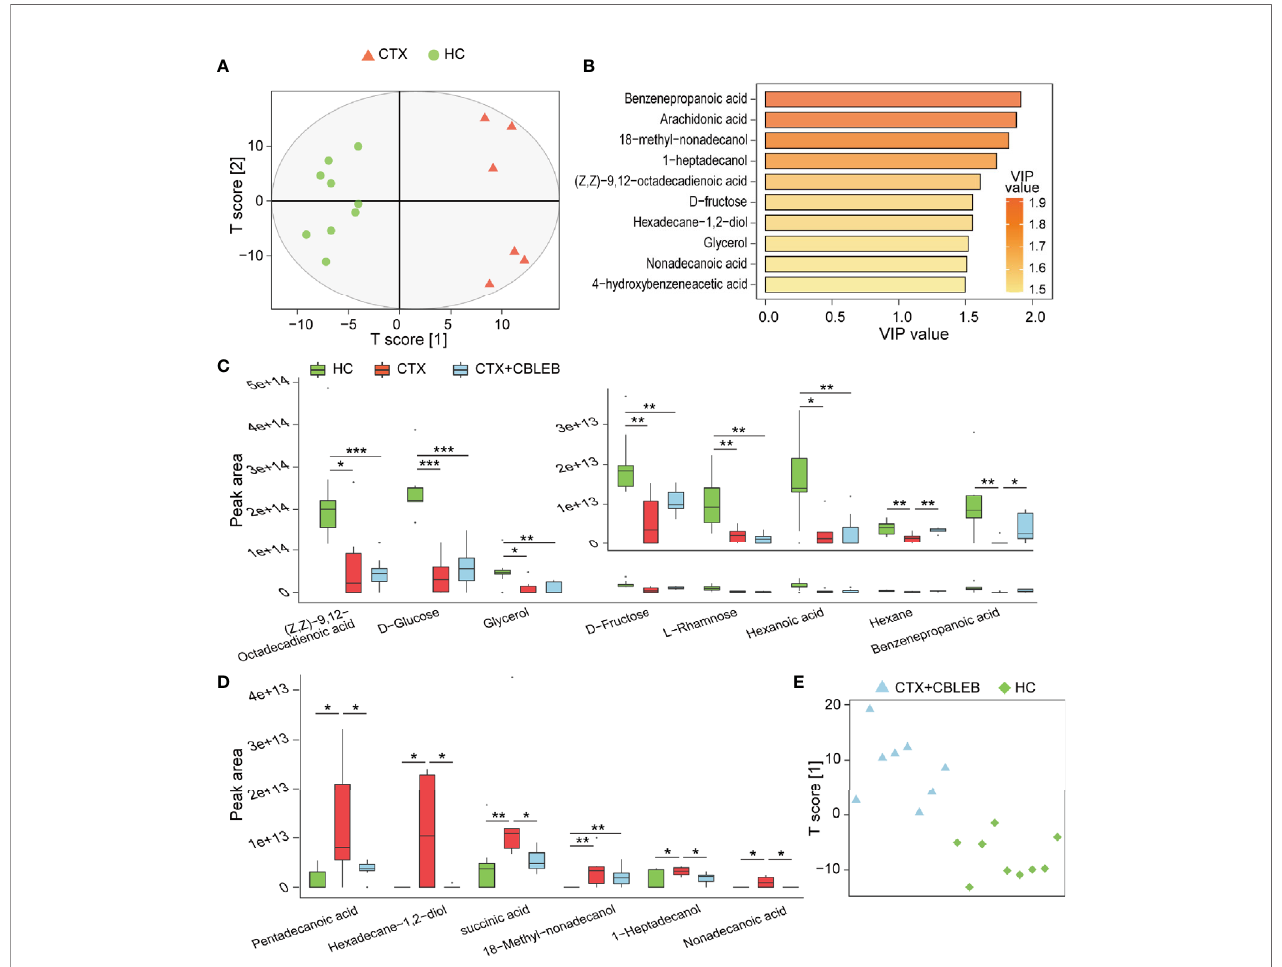
FIGURE 3 | CBLEB alleviates cyclophosphamide-induced gut metabolism disorder. (A) OPLS-DA plot illustrating clear separation of gut metabolic pro fi les of the CTX (n = 6) and HC (n = 9) groups. (B) VIP values of 10 metabolites with the highest contribution to the differences between the CTX and HC groups. (C) Levels of eight metabolites reduced in the CTX group compared with those in the HC group. (D) Levels of six metabolites that were increased in the CTX group compared with those in the HC group. (E) OPLS-DA plot illustrating that gut metabolic pro fi les of the CTX+CBLEB (n = 8) group were in distinguishable from those of the HC (n = 9) group. (* P < 0.05; ** P < 0.01; *** P <